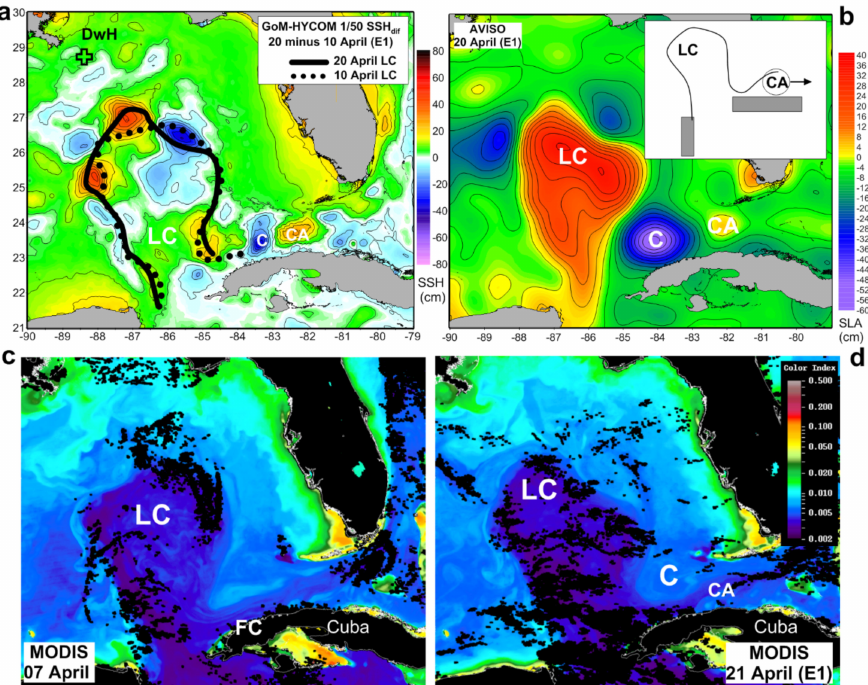
Figure 6. Horizontal distribution of ( a ) model-simulated (GoM-HYCOM 1/50) sea surface height difference (SSHdif) between 20 April (DwH accident, E1) and 10 April (before the DwH accident). ( b ) Sea level anomaly (SLA) distribution derived from the AVISO fields on 20 April (E1); the insert in ( b ) shows the respective schematic plot of the type “B” CubAN evolution during the E1 period. Respective Color Index (CI) maps, derived from Moderate Resolution Imaging Spectroradiometer (MODIS), ( c ) before (7 April) and ( d ) after (21 April) the DwH accident are also presented. The Loop Current (LC), the major cyclone (C), the CubAN (CA) and the location of the DwH platform are indicated. The model-derived SSH 17-cm contours for 10 and 20 April are marked in ( a ) with black dashed and solid lines, respectively. The light and dark blue areas in the CI maps are associated to cyclonic (C) and anticyclonic (LC/FC and CA) features,